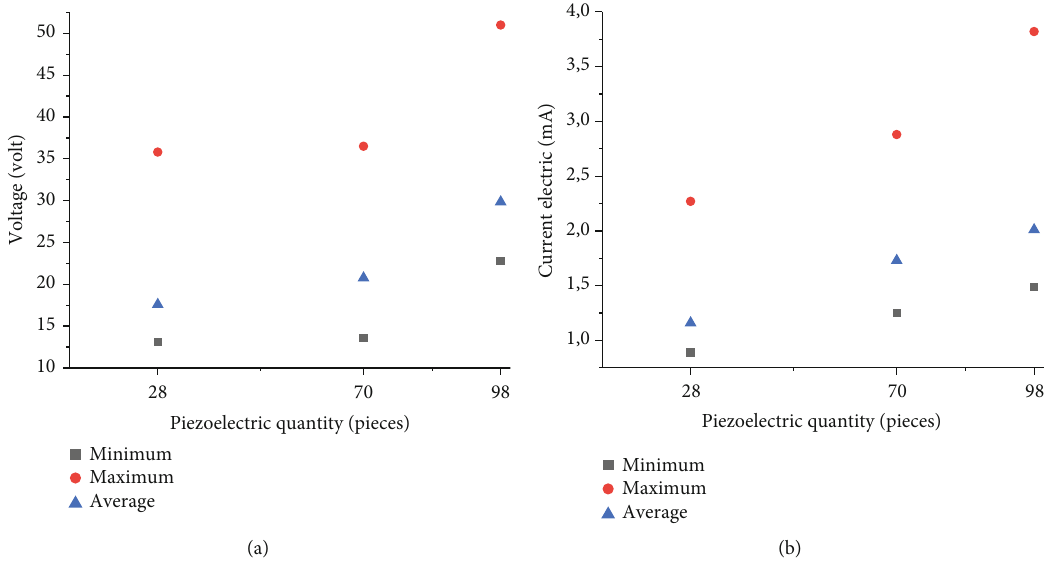
Figure 5: Piezoelectric (a) voltage; (b) electric